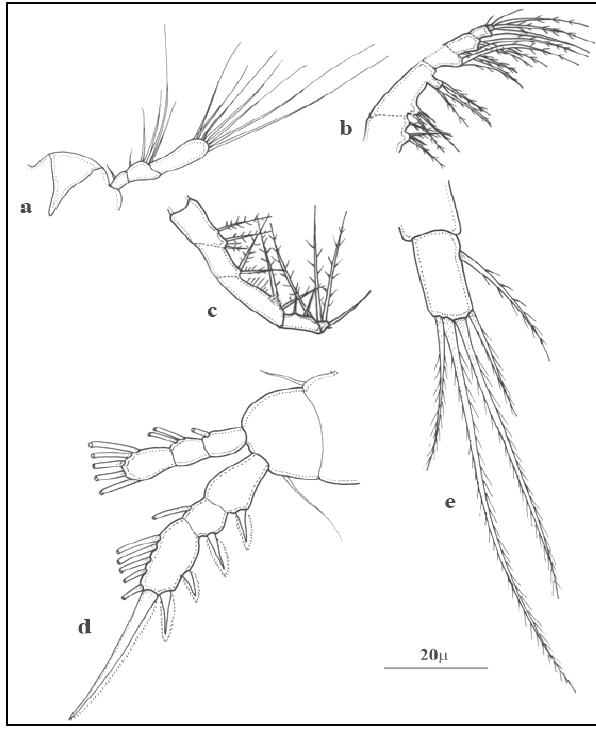
Fig. 3. Morphological characters of Oithona